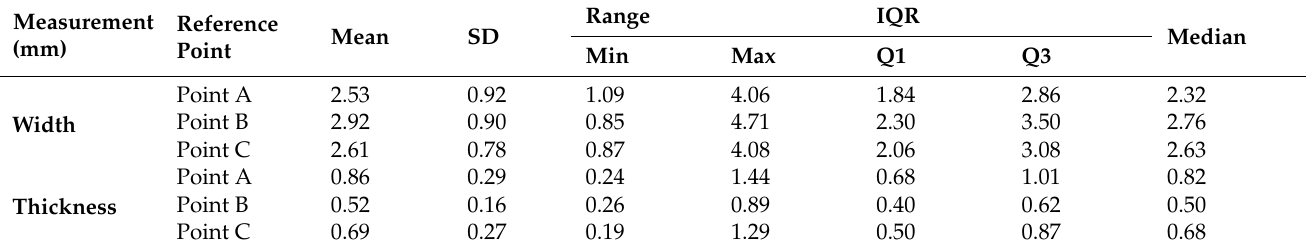
Table 2. Median and IQR for width and thickness per reference point ( n = 101): point A, the junction of the tendon and belly; point B, the mid-point for the total tendon length; and point C, the point where the tendon begins to extend. IQR: interquartile range; Q1: lower quartile; Q3: upper quartile; SD: standard